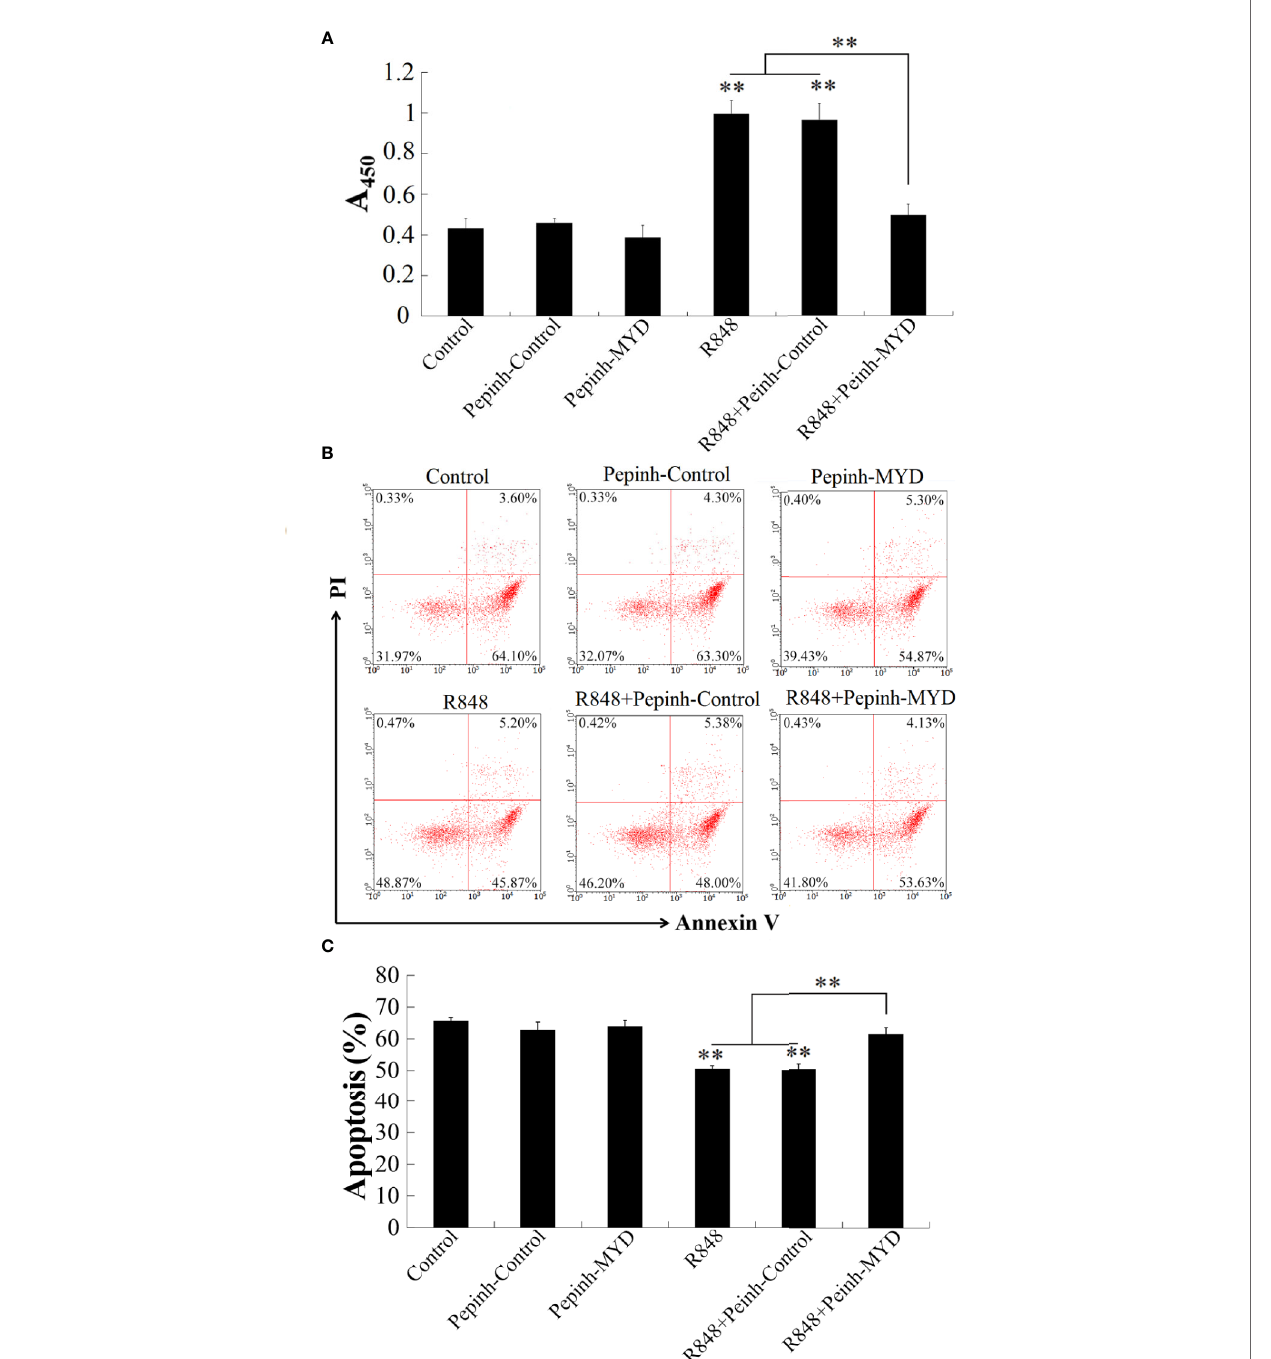
FIGURE 4 | R848-induced cellular activity through Myd88-signaling pathway. Golden pompano HKLs were treated with PBS (control), R848, Pepinh-Control, Pepinh-MYD, R848 plus Pepinh-Control, or R848 plus Pepinh-MYD. The cells were then determined for proliferation (A) , apoptosis (B) , and statistic bar chart of the apoptosis percentage (C) . Data in are presented as means ± SEM (N = 3), and (C) are presented as means ± SD (N = 3). **P < 0.01. Data in (B) are one representative of three independent